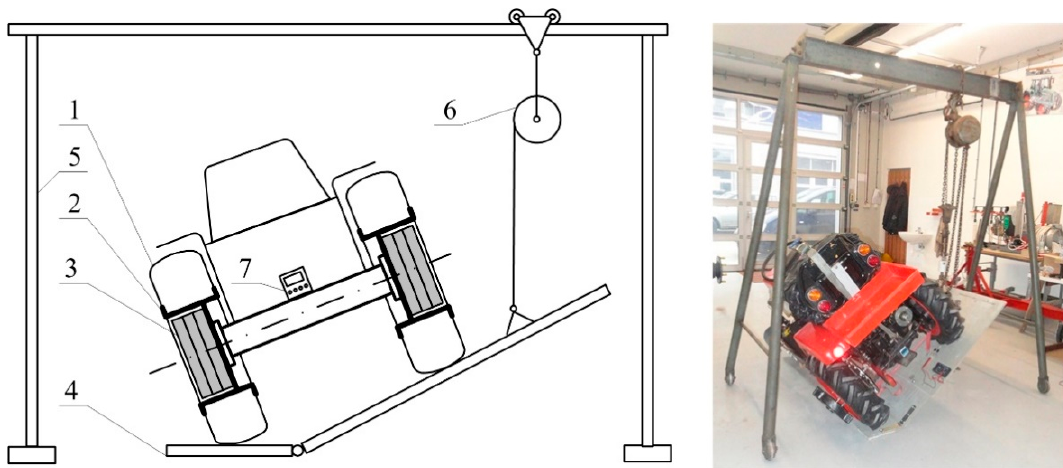
Figure 3. Test of tractor lateral stability: 1—tyre, 2—wheel rim, 3—ballast weight, 4—tilting platform, 5—portal, 6—chain hoist, 7—digital